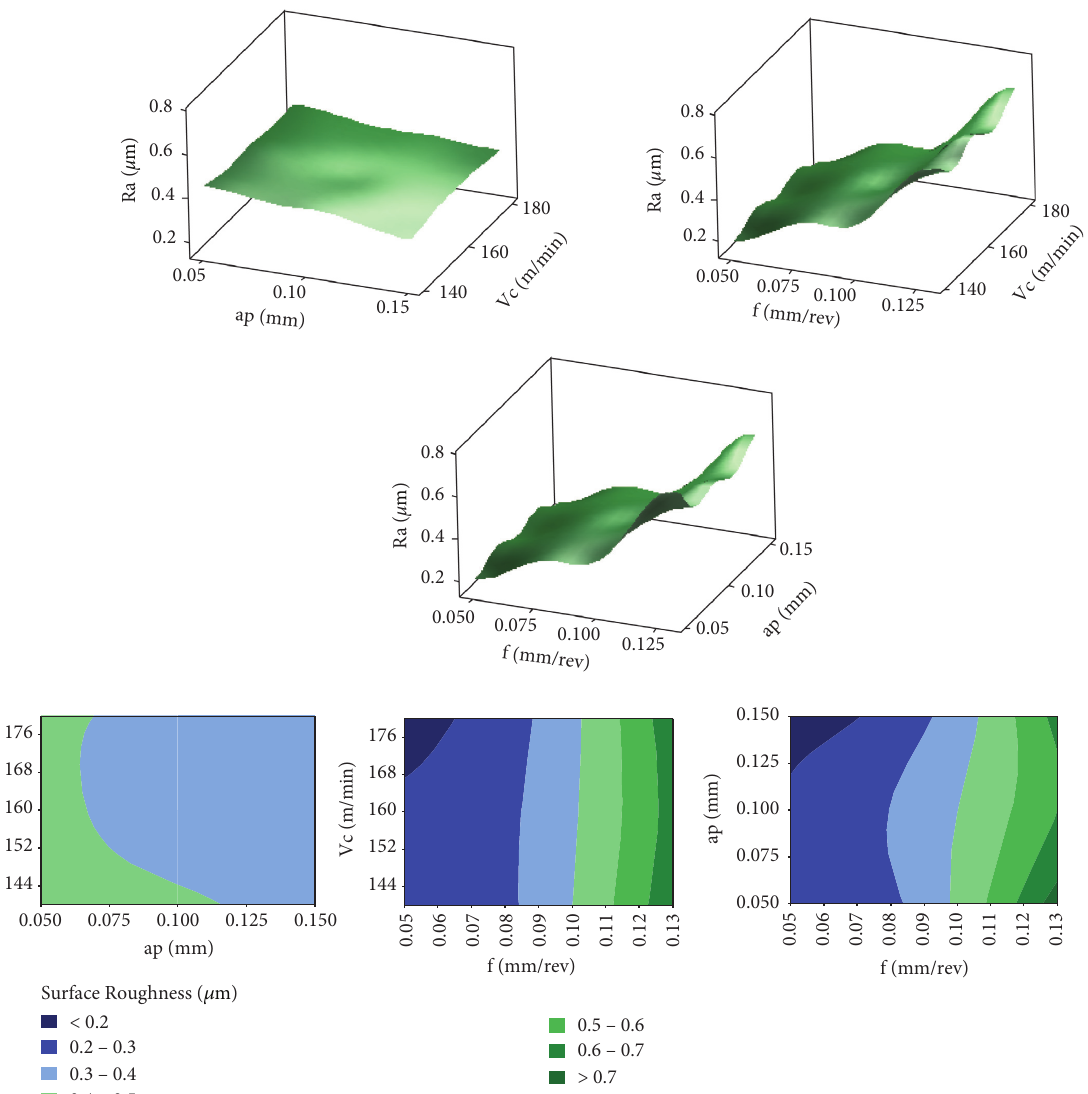
Figure 4: 3D surface plots and contour plots based on cutting parameters for surface roughness